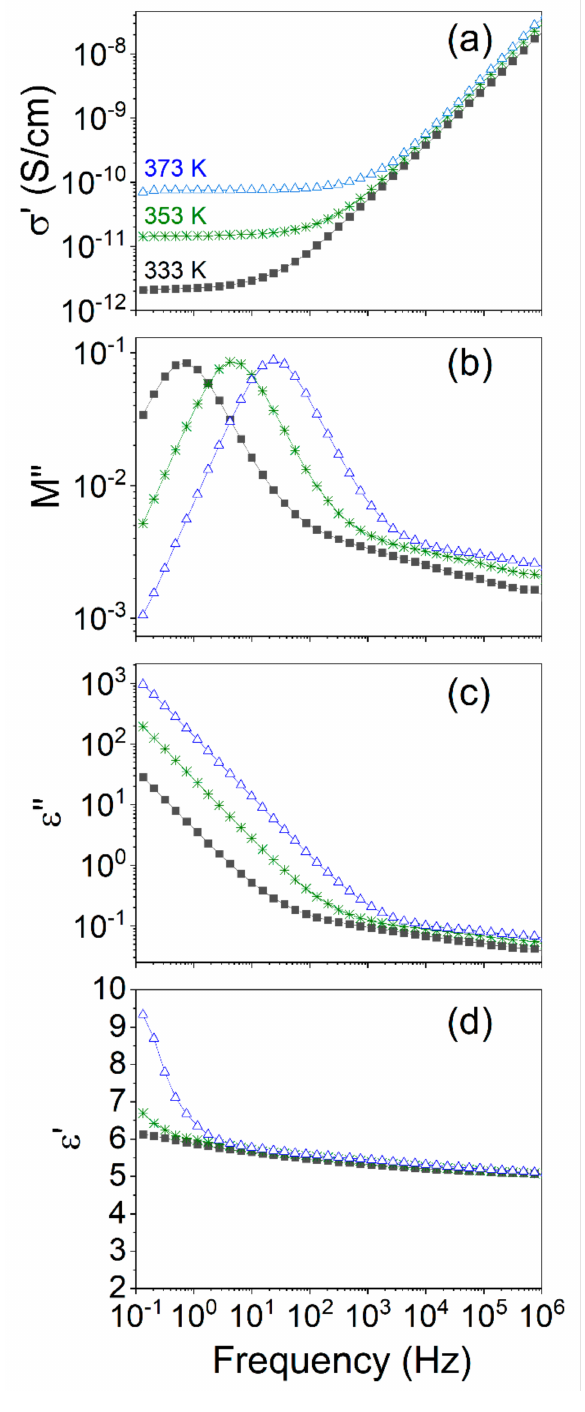
Figure 4. Different representations of the BDS data recorded for bpyPDMS-ZnCl 2 at a few tempera- tures 333, 353, and 373 K namely, ( a ) the real part of the conductivity ( σ ’), ( b ) the imaginary part of the modulus (M”), ( c ) the imaginary part of the dielectric permittivity ( ε ”), and ( d ) the real part of the dielectric permittivity ( ε ’) vs.